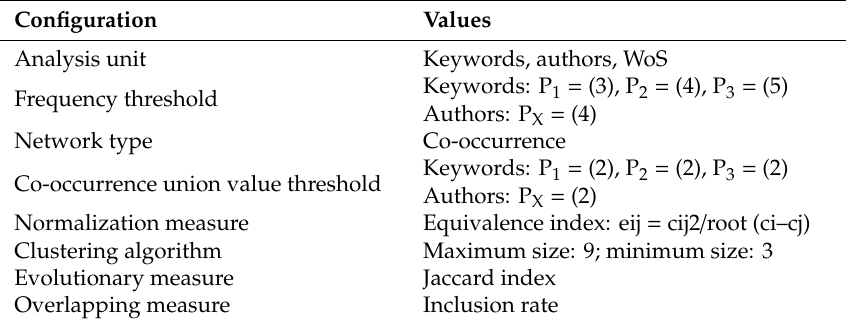
Table 1. Production indicators and inclusion